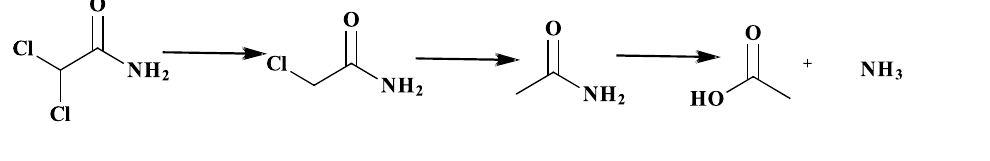
Table 3. N 2 adsorption-desorption isotherms summary. Sample